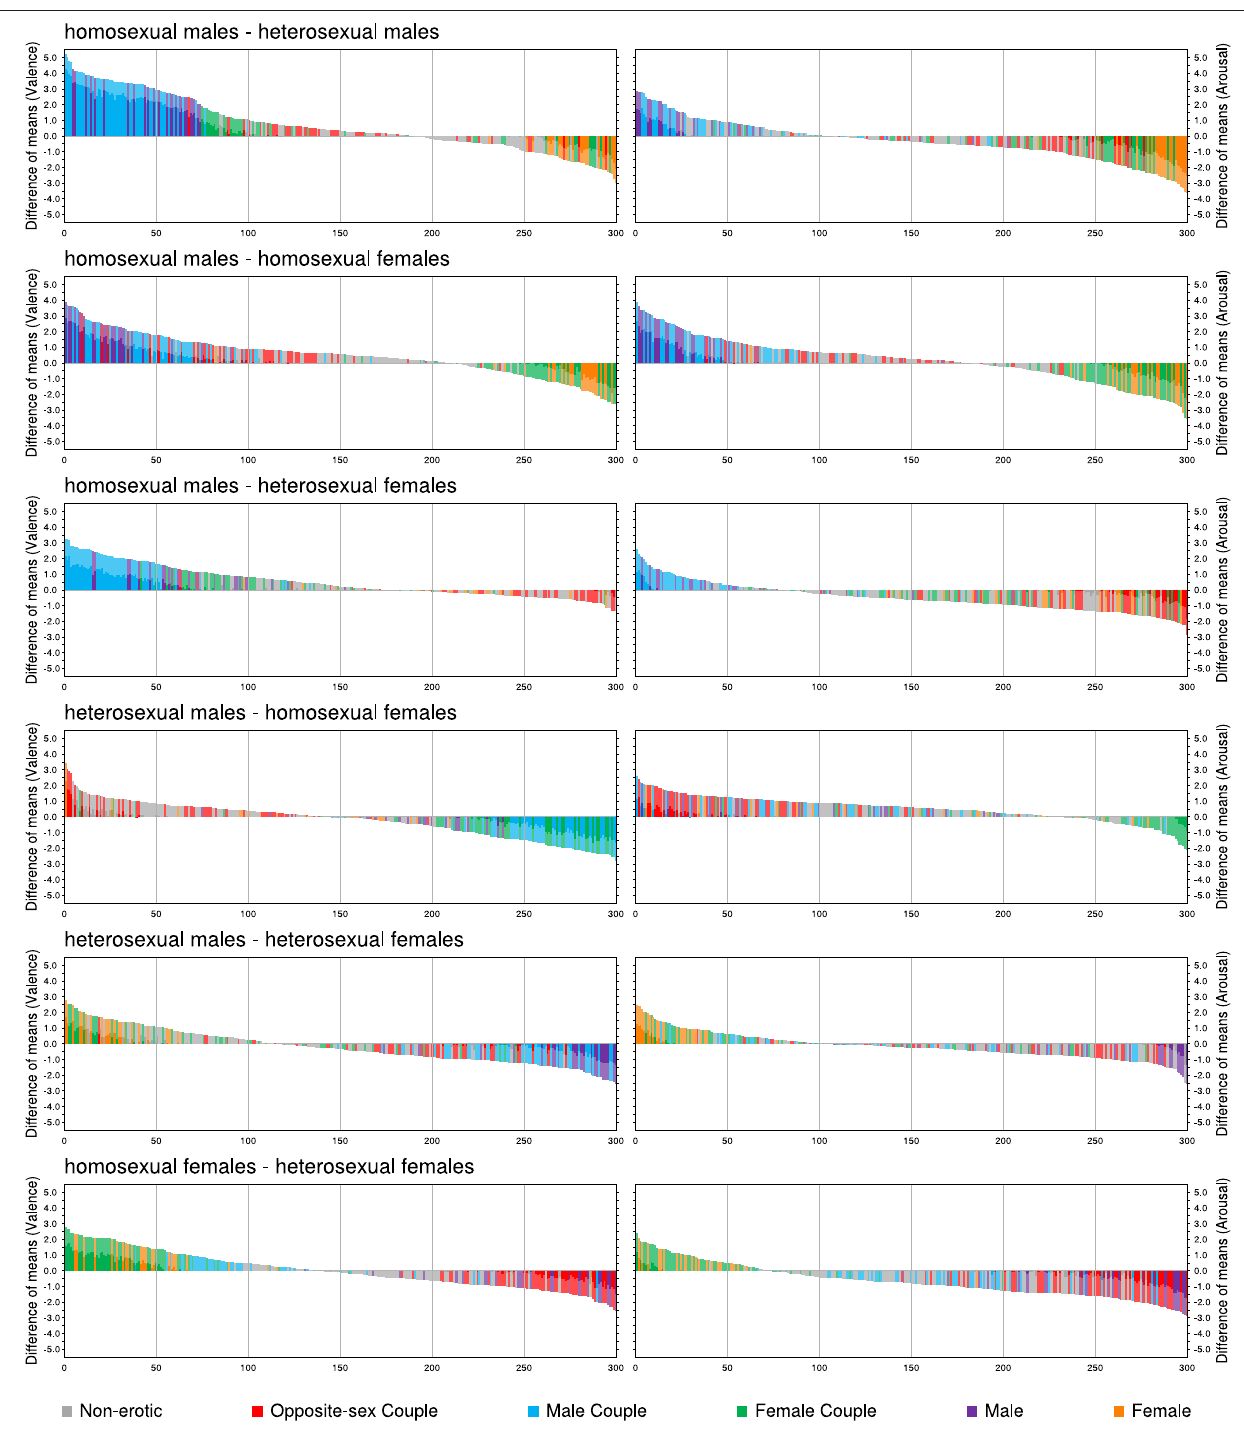
FIGURE 4 | Differences in the mean ratings between the respective samples (HoM—HeM, HoM—HoF, HoM—HeF, HeM—HoF, HeM—HeF, HoF—HeF) as obtained for each of the NAPS ERO images (200 erotic, 100 non-erotic), for valence and arousal separately. Each bin represents a difference in the mean ratings of a given image. Significant differences ( p < 0 . 05 ) are marked by a darkening of a bin. Bins are sorted according to the size of a difference in mean ratings. Images rated higher by one group in a given comparison are aggregated on both sides of the plot, whereas images for which no difference was obtained can be found around the middle of the